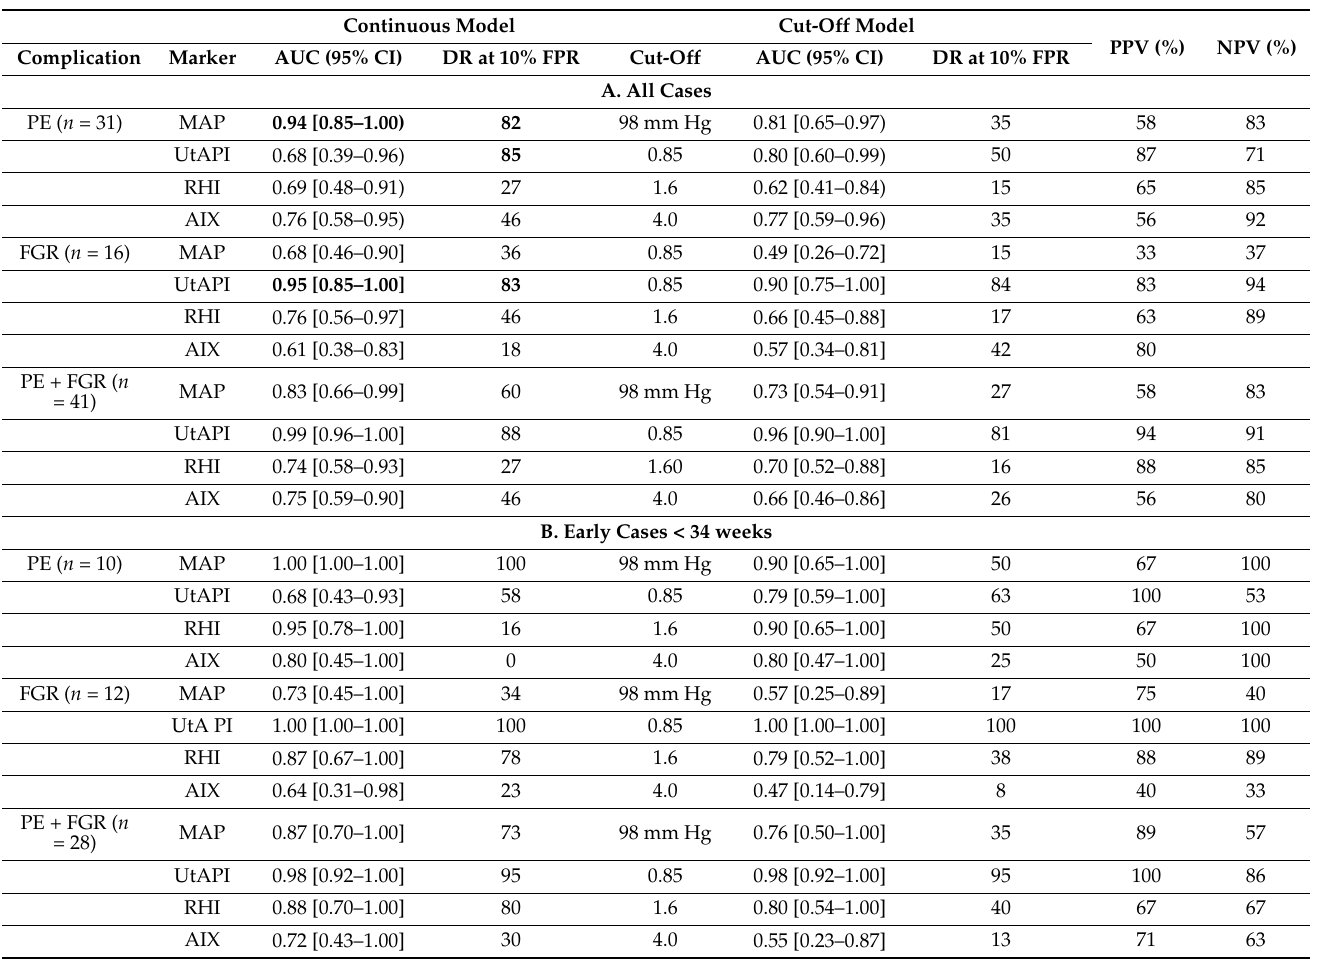
Table 3. Accuracy of Receiver Operation Characteristic Curves (ROC) for Single Markers in Each Complication